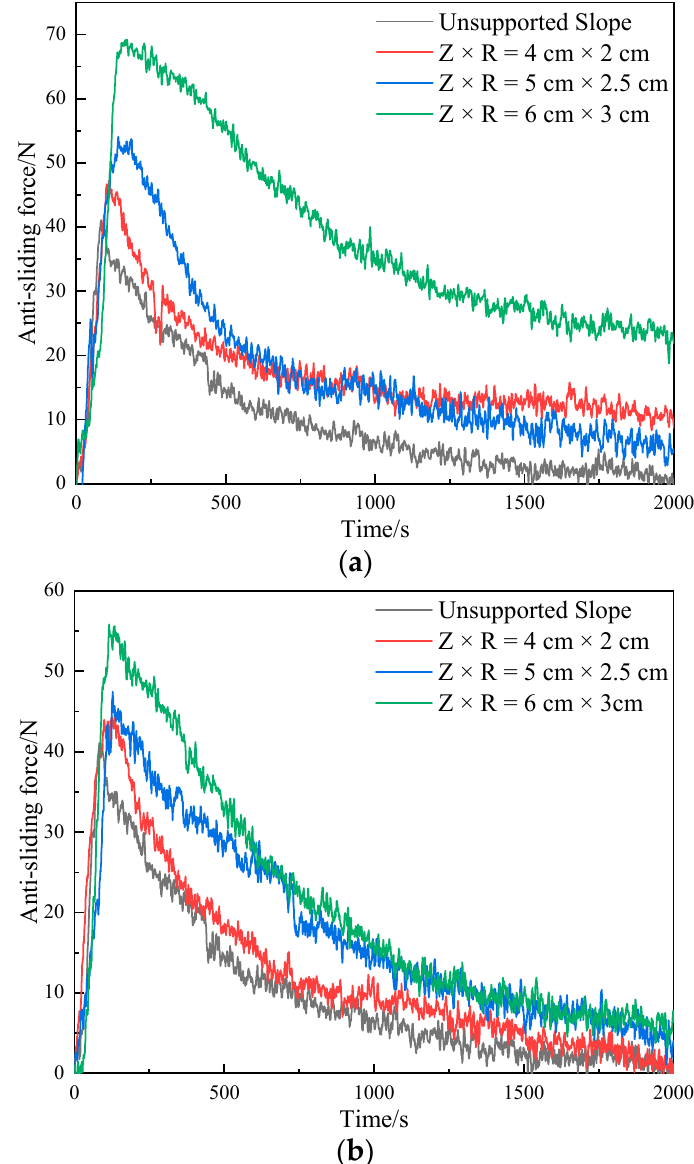
Figure 7. Effect of volume of tap-like root system on anti-sliding force with constant plant spacing. ( a ) Square distribution; ( b ) Staggered distribution.